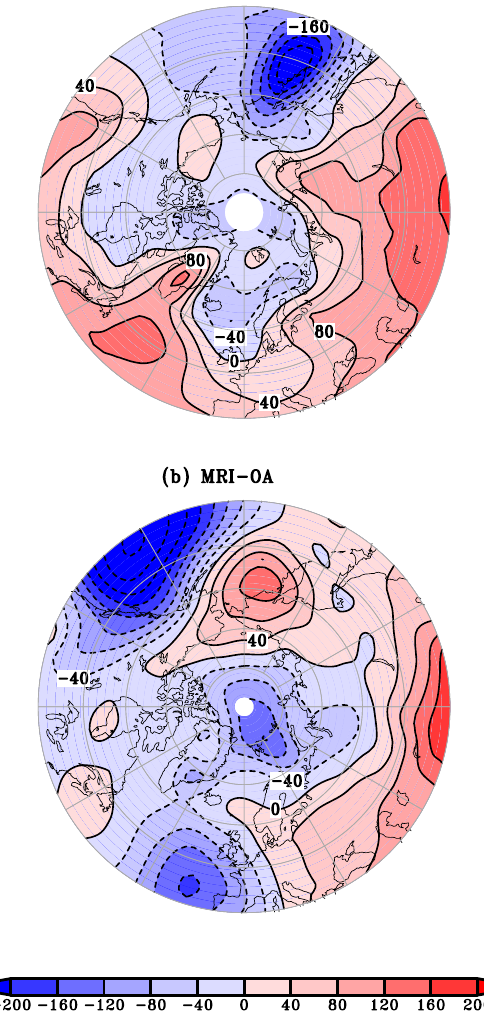
Fig. 10. Change in DJF mean sea level pressure (Pa) for (a) FOAM-OA, (b)